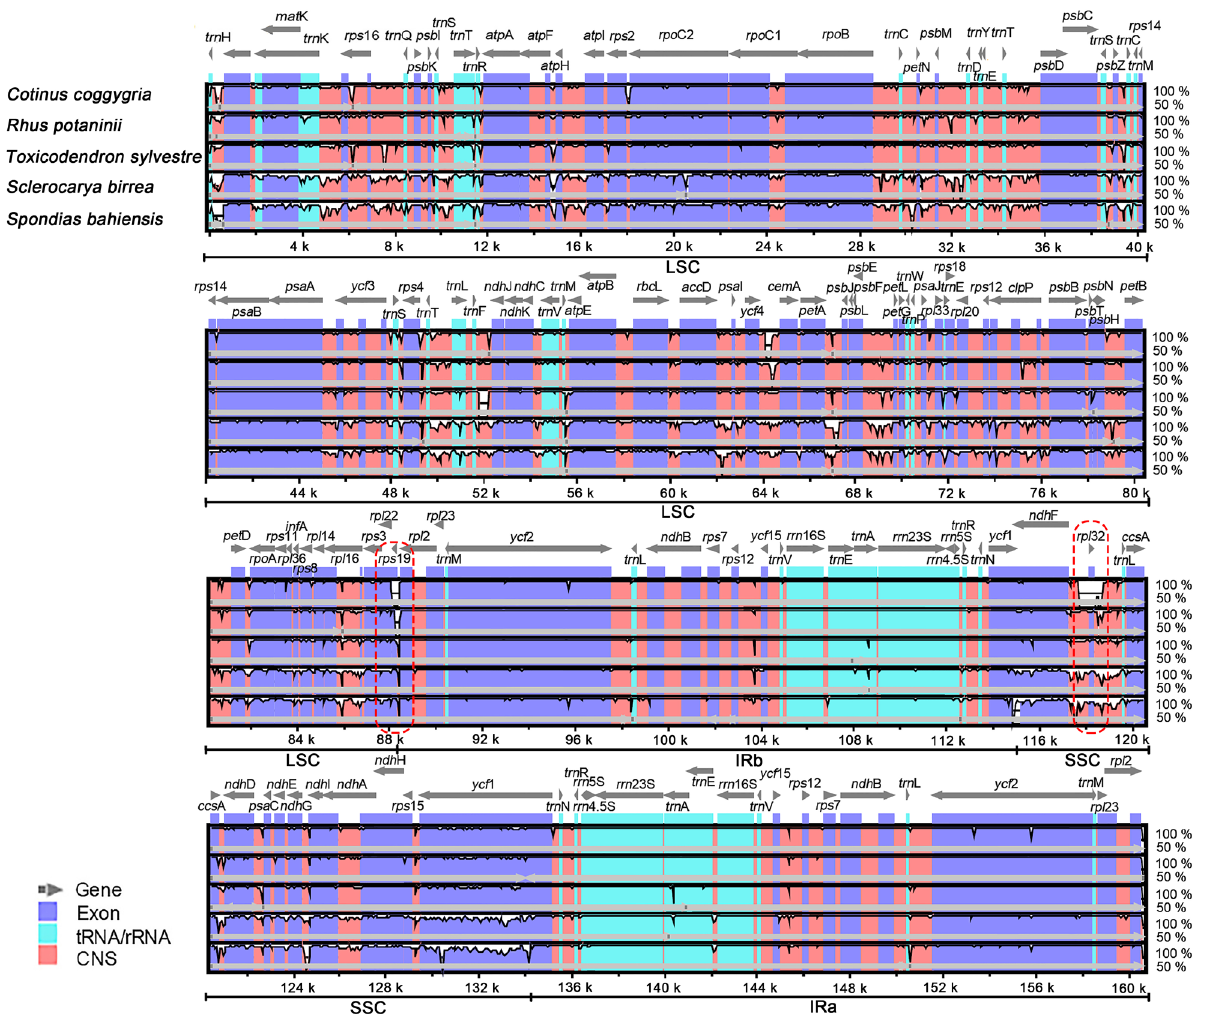
Figure 3 – Comparison of the cp genomes in six Anacardiaceae species by using mVISTA. The genes were represented as gray arrows on the top of the alignment. Different regions are labeled with different colors. The pink regions are “Conserved Non-Coding Sequences” (CNS), the dark blue regions are exons, and the light-blue regions are tRNA or rRNA. 50% and 100% refer to the similarity among sequences. Gray arrows above the aligned sequences represent genes and their orientation. In particular, two genes ( rps 19 and rpl 32) are circled in red, as they are quite different in these taxa. The deletion of a large fragments in C. coggygria led to the loss of rpl 32